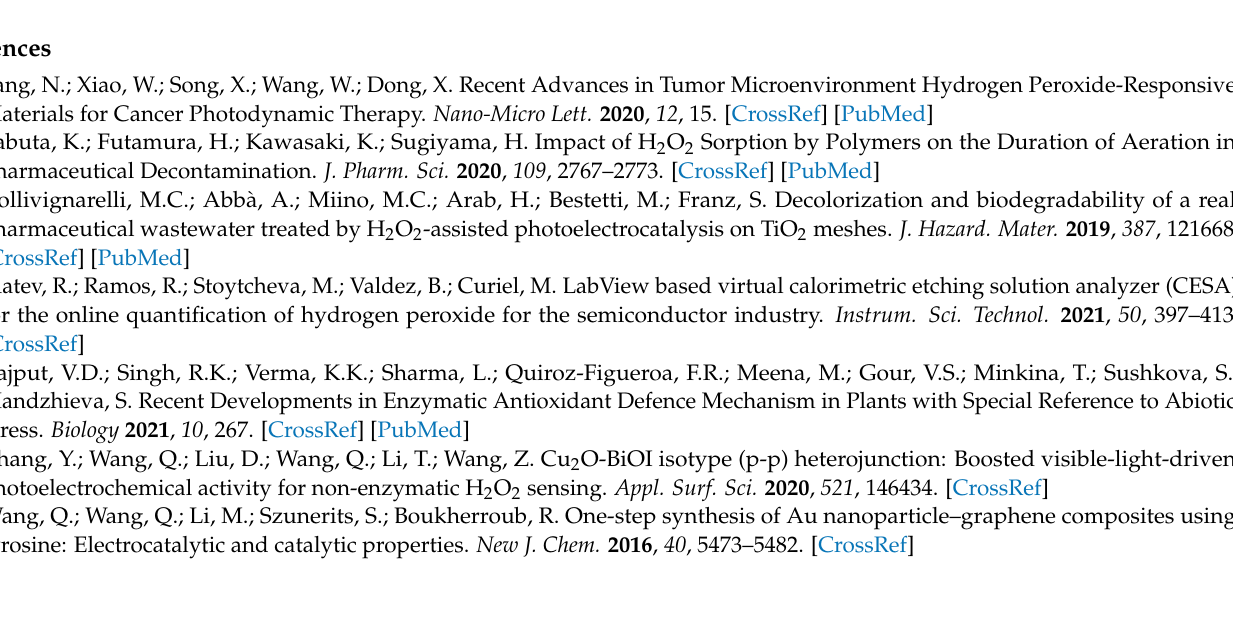
solution to medical disinfectant with a bias of − 0.5